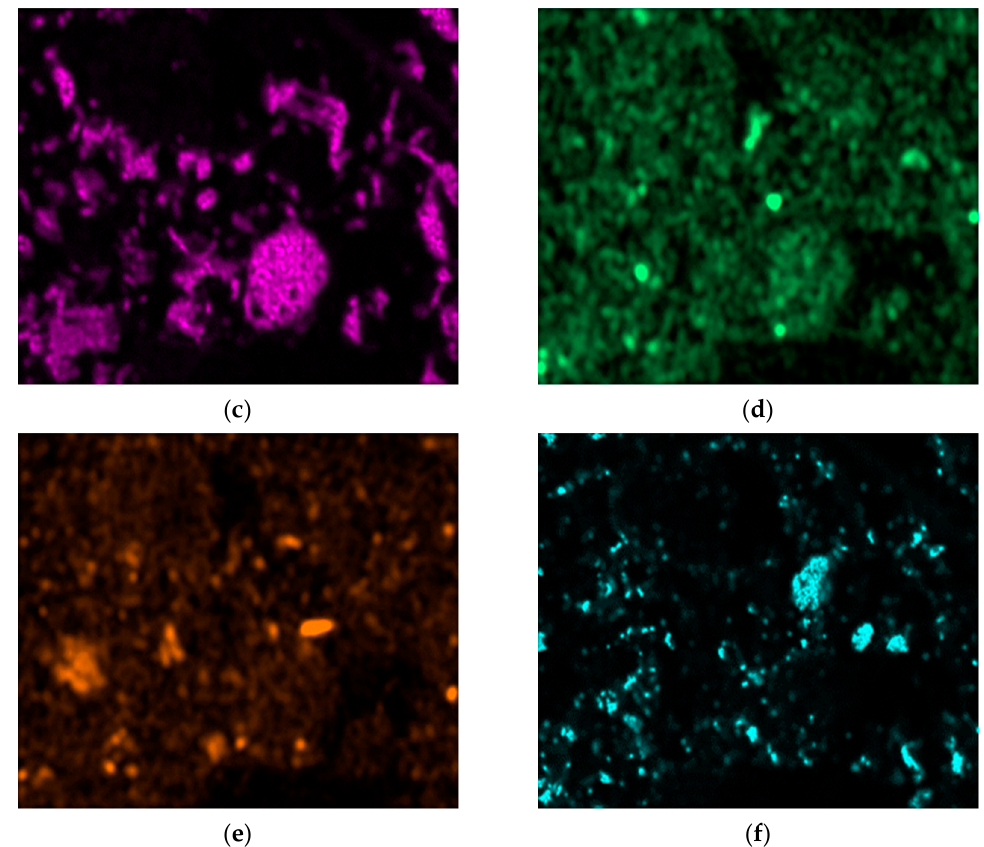
Figure 4. Distribution of the elements: ( a ) fraction 1; ( b ) distribution of the elements on the surface;